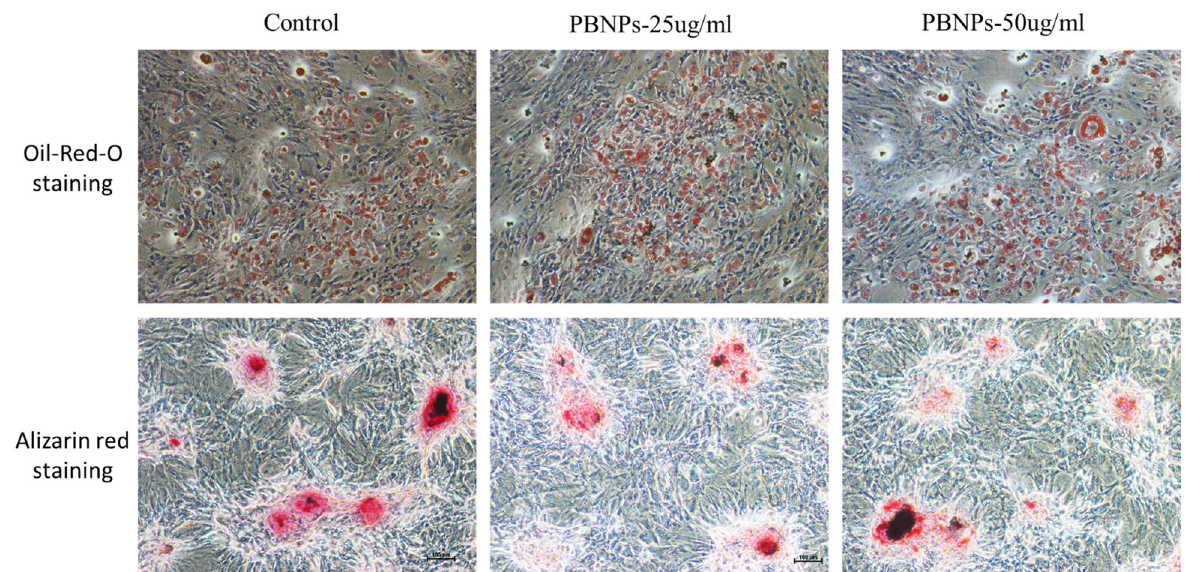
MSCs, like other stem cells, have the potential to differenti- ate bone, cartilage, fat, muscle, and cardiac cells, which have become an important source for regenerative medicine.